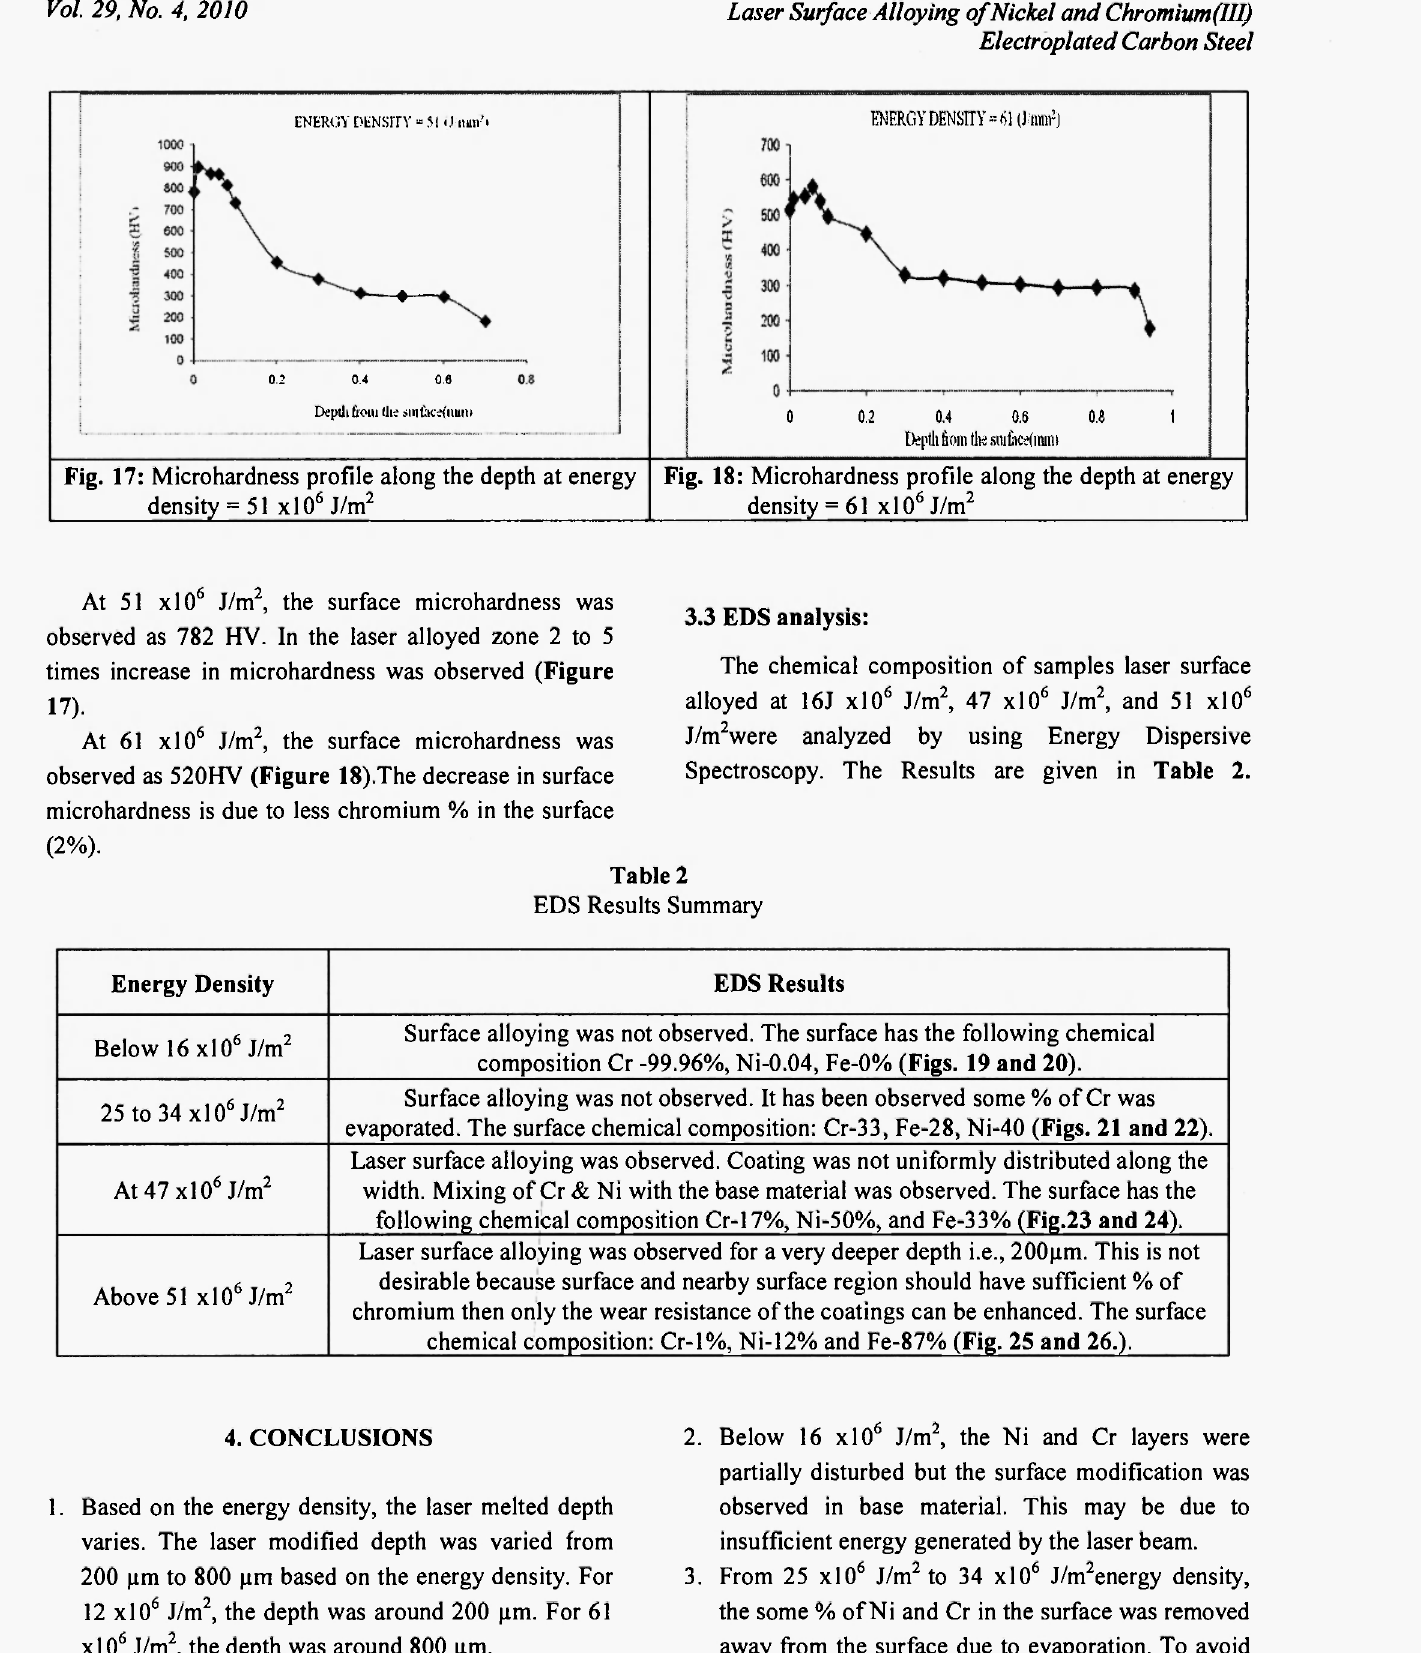
Fig. 17: Microhardness profile along the depth at energy density = 51 xlO 6 J/m 2